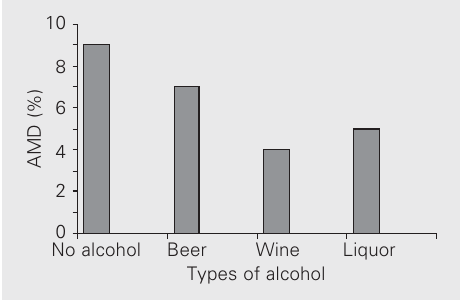
Figure 3. The protective effect of alcohol on age-related macu- lar degeneration (AMD). Repro- duced from Ref. 25, with per-